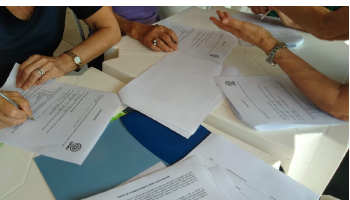
Figure 1. G1 filling out the questionnaire and engaging in